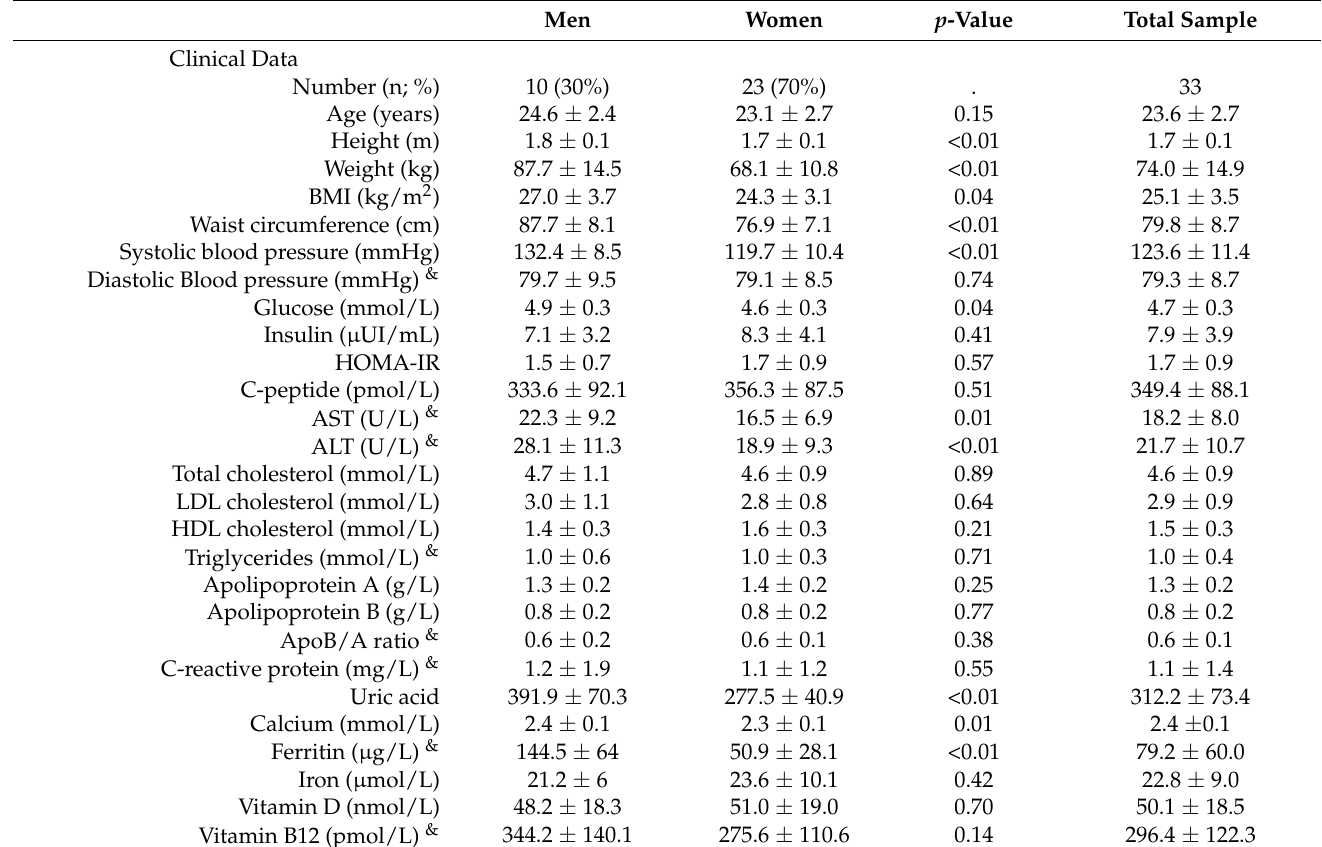
Table 1. Baseline clinical, dietary, and physical activity data according to sex. Men Women p -Value Total